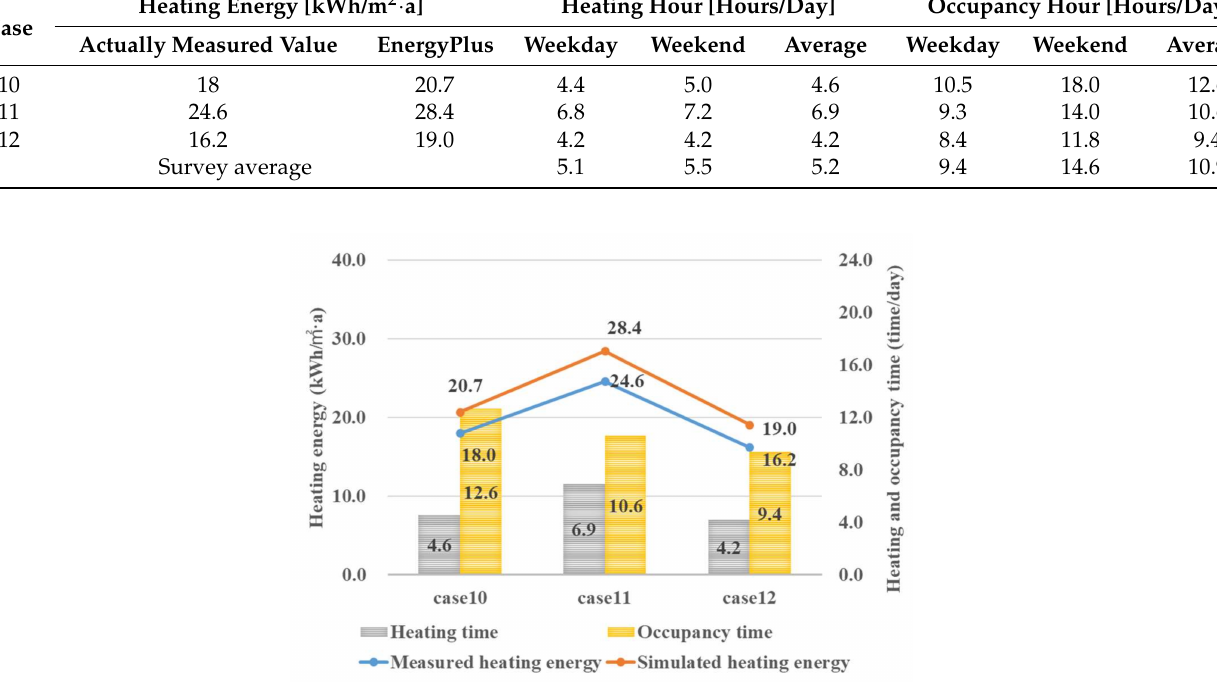
Figure 19. Comparison between the measured heating energy consumption and simulation as well as living pattern (case